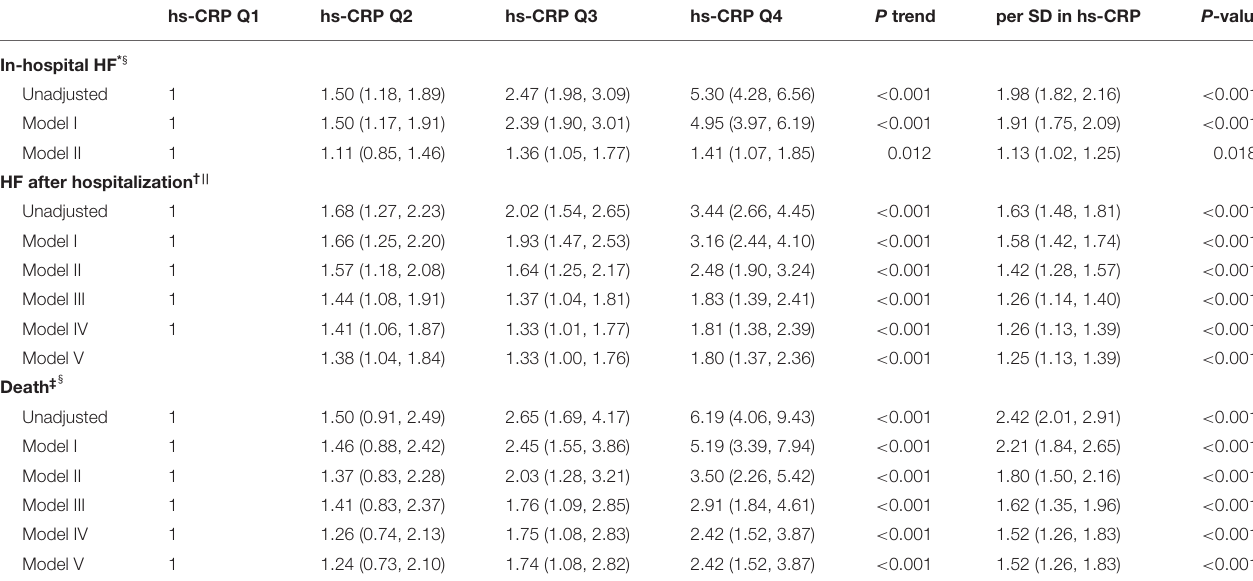
TABLE 2 | Odds ratios, sub-distributional hazard ratios or hazard ratios (95% confidence intervals) associated with hs-CRP for outcomes after AMI. hs-CRP Q1 hs-CRP Q2 hs-CRP Q3 hs-CRP Q4 P trend per SD in hs-CRP